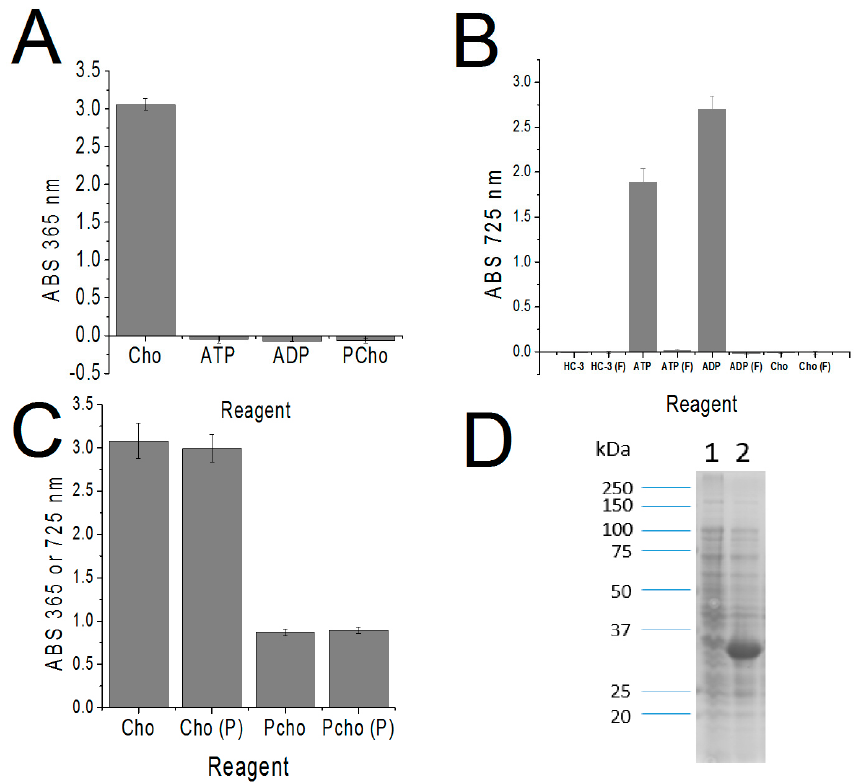
Figure 1. Validation of the colorimetric method. A 1 mM concentration of each reagent was assayed, except for 2.7 mM of HC-3. ( A ) Triiodide reactions with each component of the Chok reaction: choline (Cho), ATP, and phopshocholine (PCho). ( B ) Analysis of MBD absorbance measurements after processing of each compound with triiodide step alone and the combined steps of triiodide and charcoal (marked with an (F)). ( C ) Absorbance values of PCho and Cho samples detected with and without processing (P). ( D ) SDS-PAGE of extracts of uninduced (1) and induced (2) BL21 (DE3) cells transformed with S. pneumoniae LicA , the gene coding for sChok.